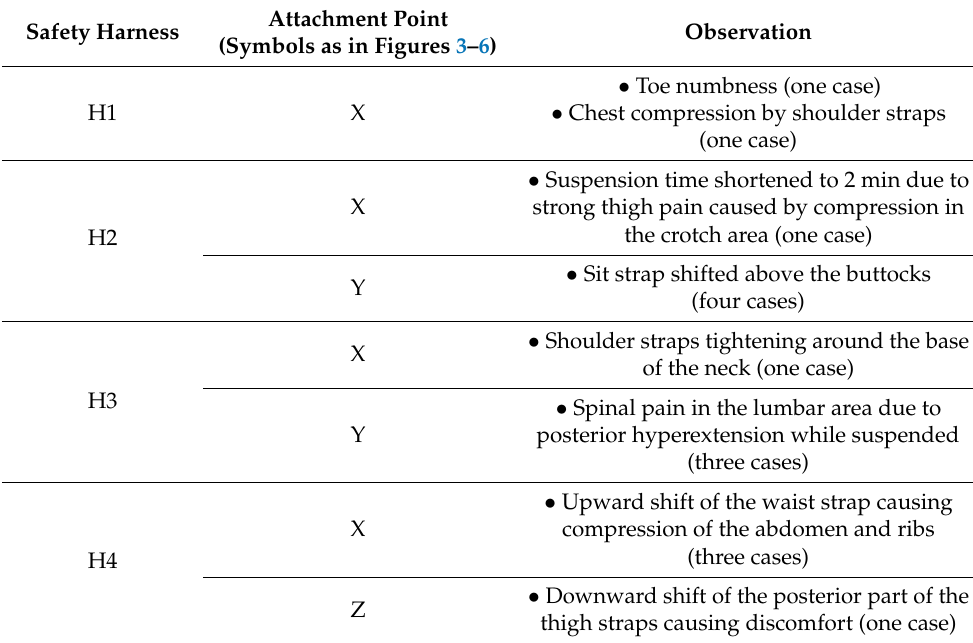
Table 2. Participants’ observations from the